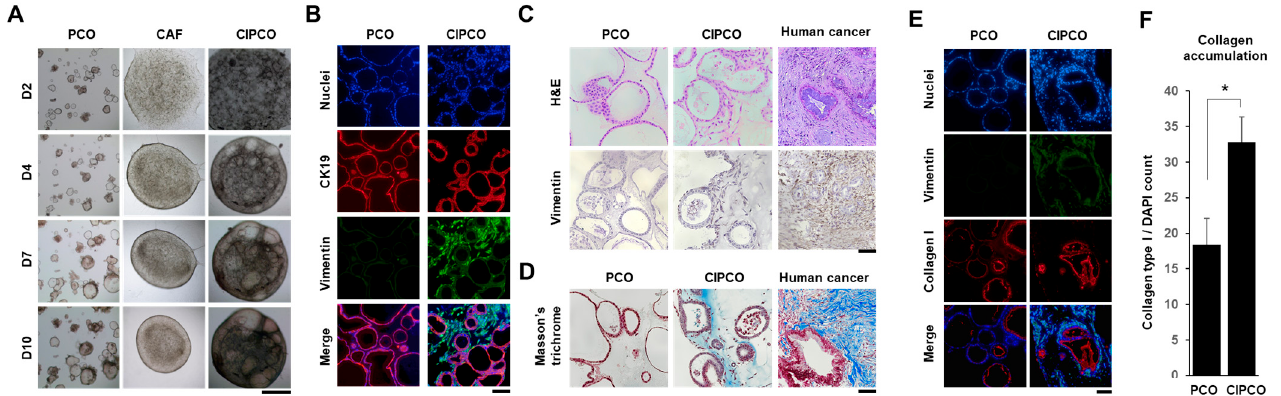
Figure 1. Development of cancer-associated fibroblast (CAF)-integrated pancreatic cancer organoid (CIPCO) model and its morphologic characteristics. The CIPCOs were incubated for 2–10 days at 37 °C under 5% CO 2 . CIPCO analysis was performed on day 5. ( A ) Bright-field images of pancreatic cancer organoids (PCOs), CAFs, and CIPCOs on days 2, 4, 7, and 10. Bar = 500 µm. ( B ) Immunofluorescence images of the PCO and CIPCO models labeled with CK19 and vimentin. Bar = 100 µ m. ( C ) Comparison of H&E and vimentin-stained images of PCOs, CIPCOs, and human pancreatic cancer tissues. Bar = 200 µ m. ( D ) Comparison of Masson’s trichrome-stained images of PCOs, CIPCOs, and human pancreatic cancer cells. Bar = 500 µ m. ( E ) Immunofluorescence images of PCOs and CIPCOs labeled with collagen I. Bar = 100 µ m. ( F ) Quantitative analysis of the relative fluorescence intensity of collagen I in PCOs and CIPCOs. ( n = 6) * p <